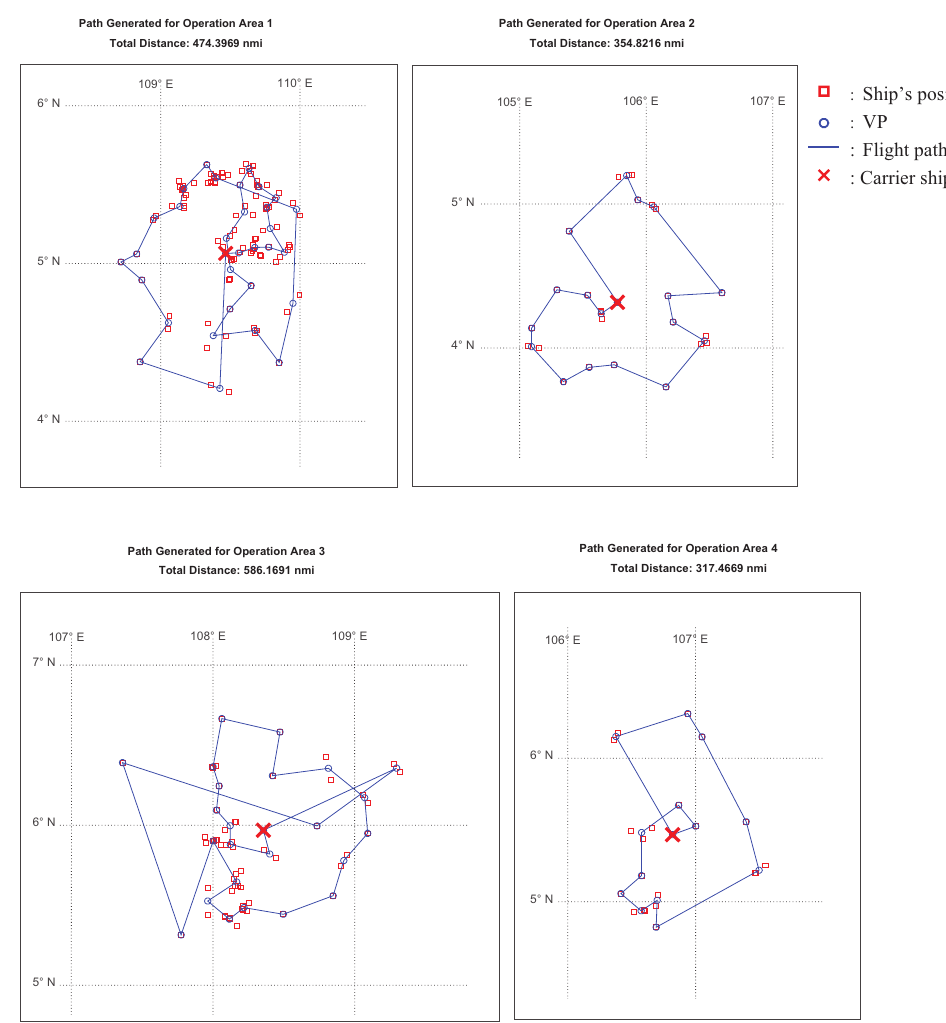
Figure 8. UAV routes for all